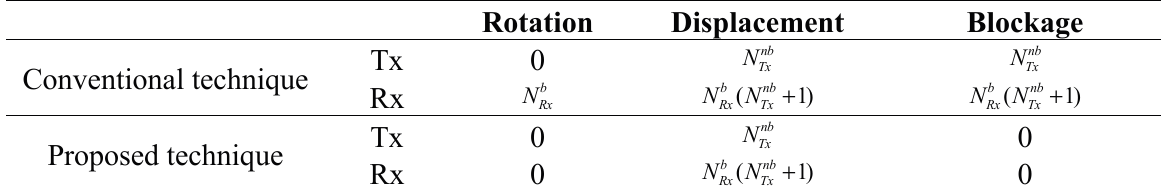
Table 3. Number of beam switches required for beam-tracking.